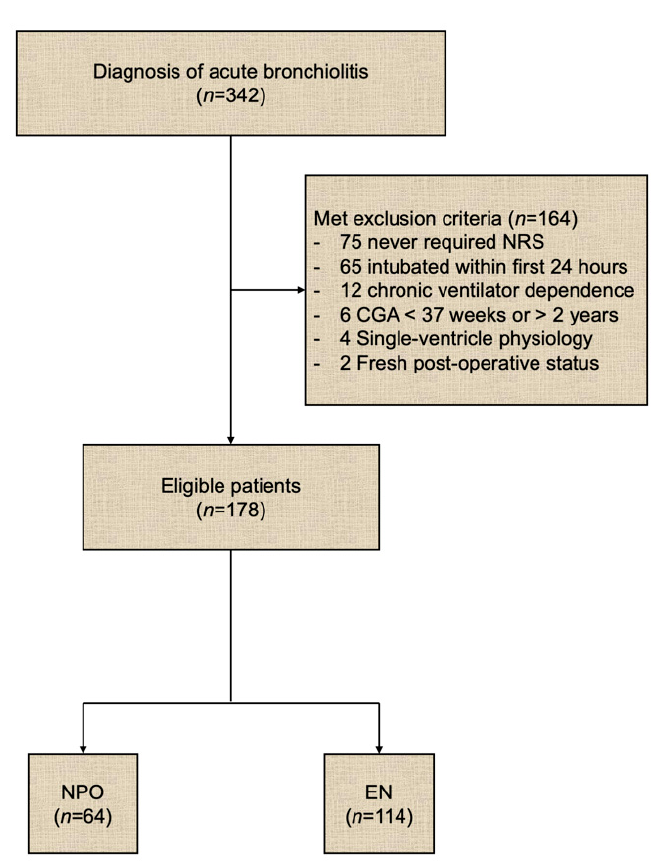
Figure 1. Flow diagram of patient enrollment. CGA = corrected gestational age, EN = enteral nutrition, NPO = nil per os (nothing by mouth), NRS = non-invasive respiratory support.